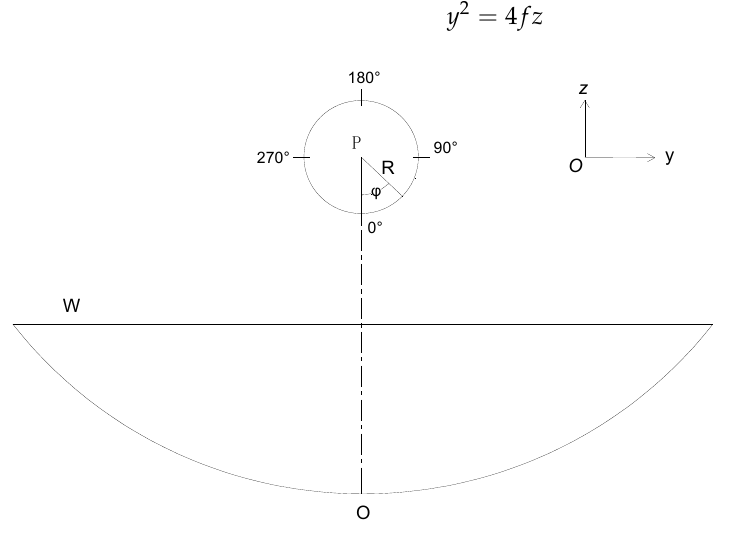
Figure 1. Schematic of a PTC